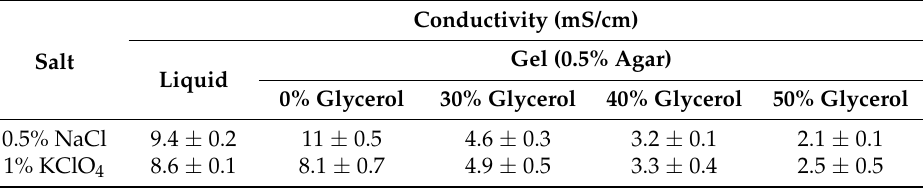
Table 1. Conductivity of electrolytes with 0.5% NaCl or 1% KClO 4 at room